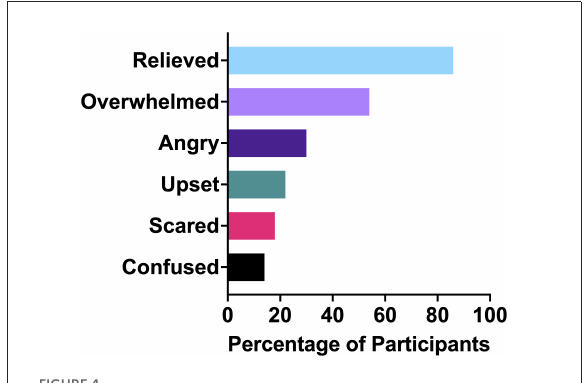
FIGURE4 Emotions endometriosis patients felt upon receiving their